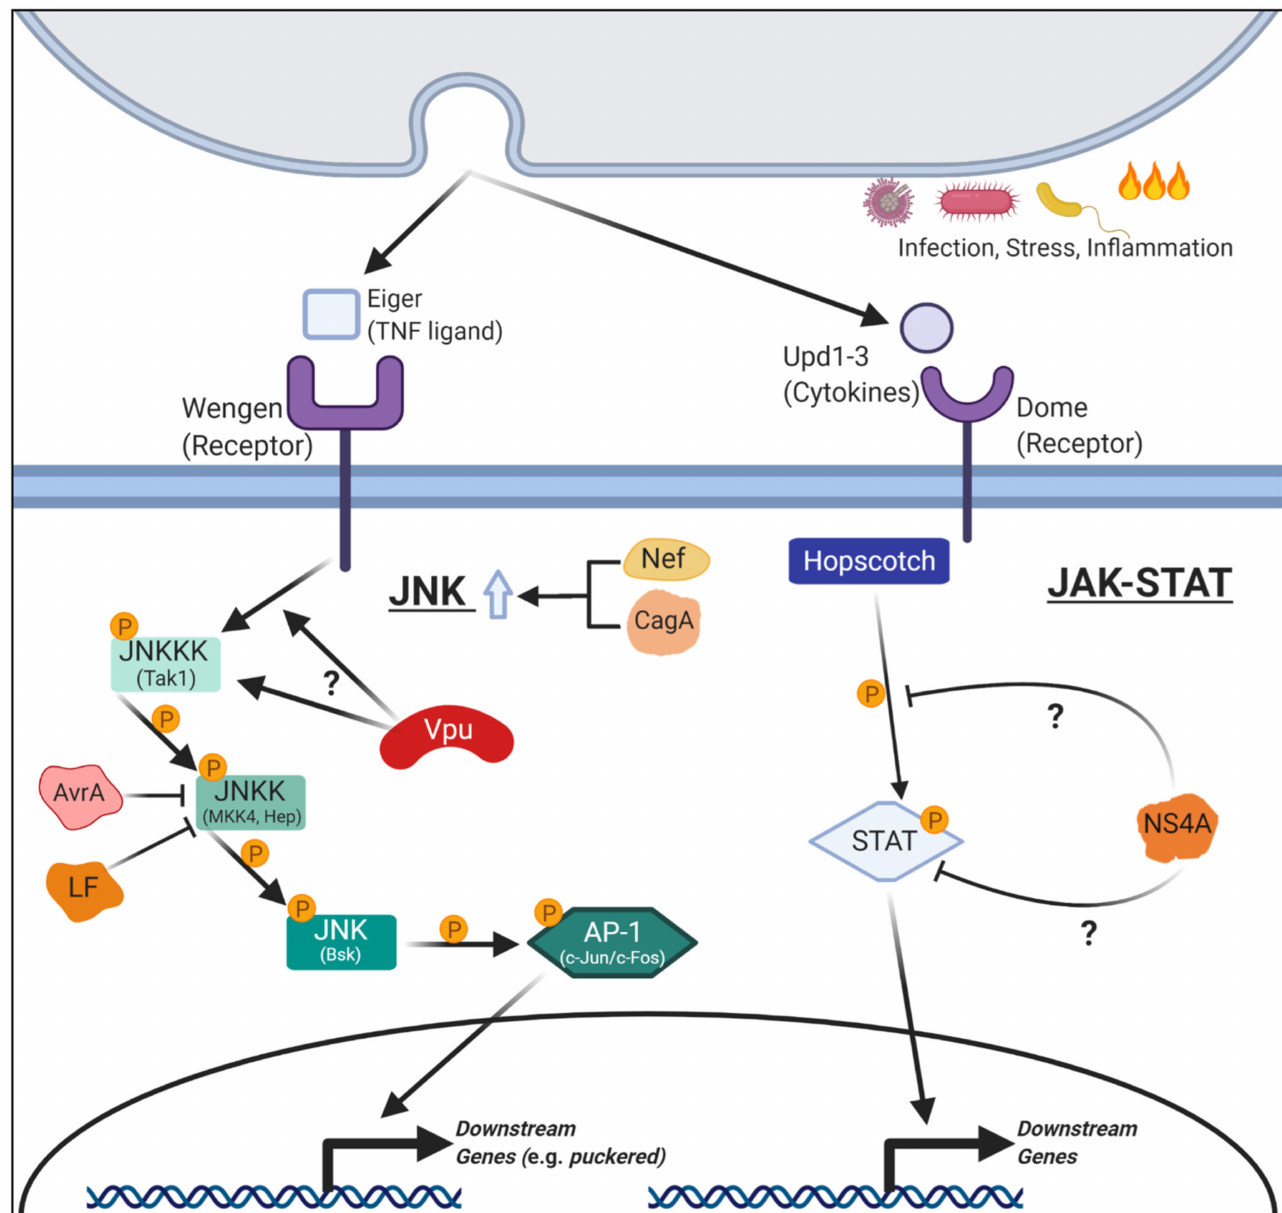
Figure 2. Virulence factors that affect stress-induced signaling pathways studied in Drosophila . Core components of the JNK ( left ) and JAK-STAT ( right ) pathways are depicted along with pathogenic proteins that target these pathways. Host proteins shown in cool colors and pathogenic proteins (AvrA ( S. enterica ), CagA ( Helicobacter pylori ), LF ( Bacillus anthracis ), Nef (HIV), NS4A (ZIKV), Tax1 (HTLV-1), and Vpu (HIV)) are shown in warm